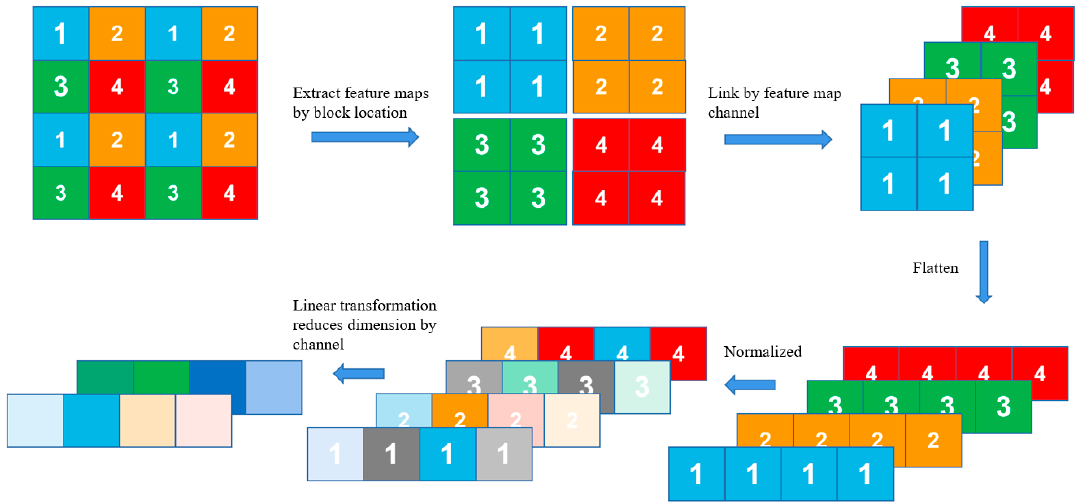
Figure 2. Process of Patch Merging.